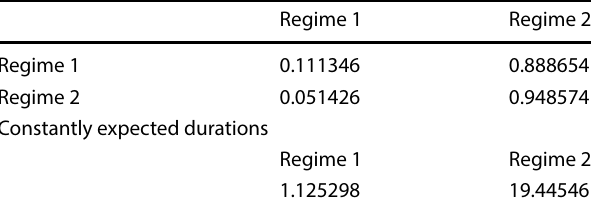
Table 2 Constant Markov transition probabilities and expected durations